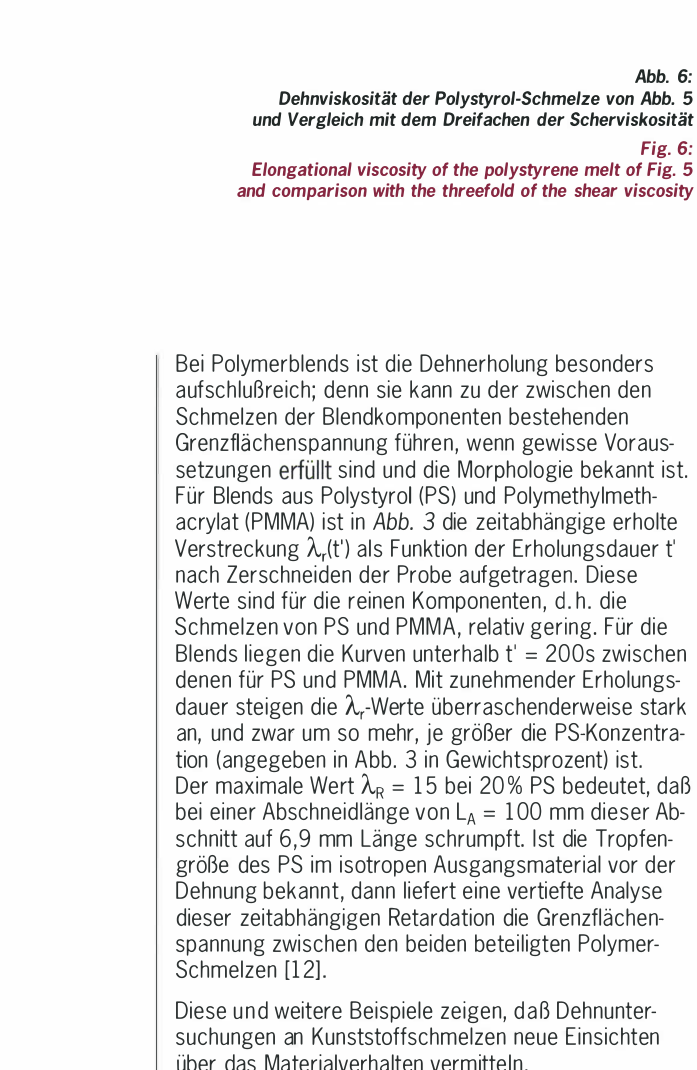
Elongational viscosity of the polystyrene melt of Fig. 5 and comparison with the threefold of the shear